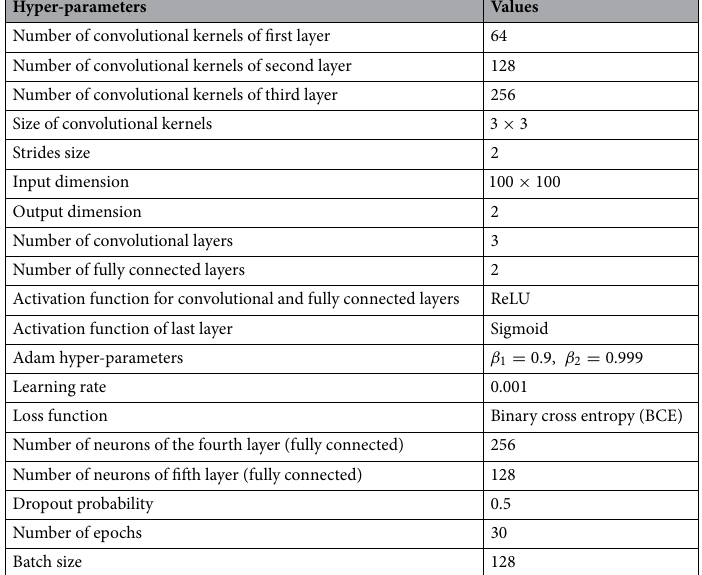
Table 6. Implementation details of the CNN trained on image